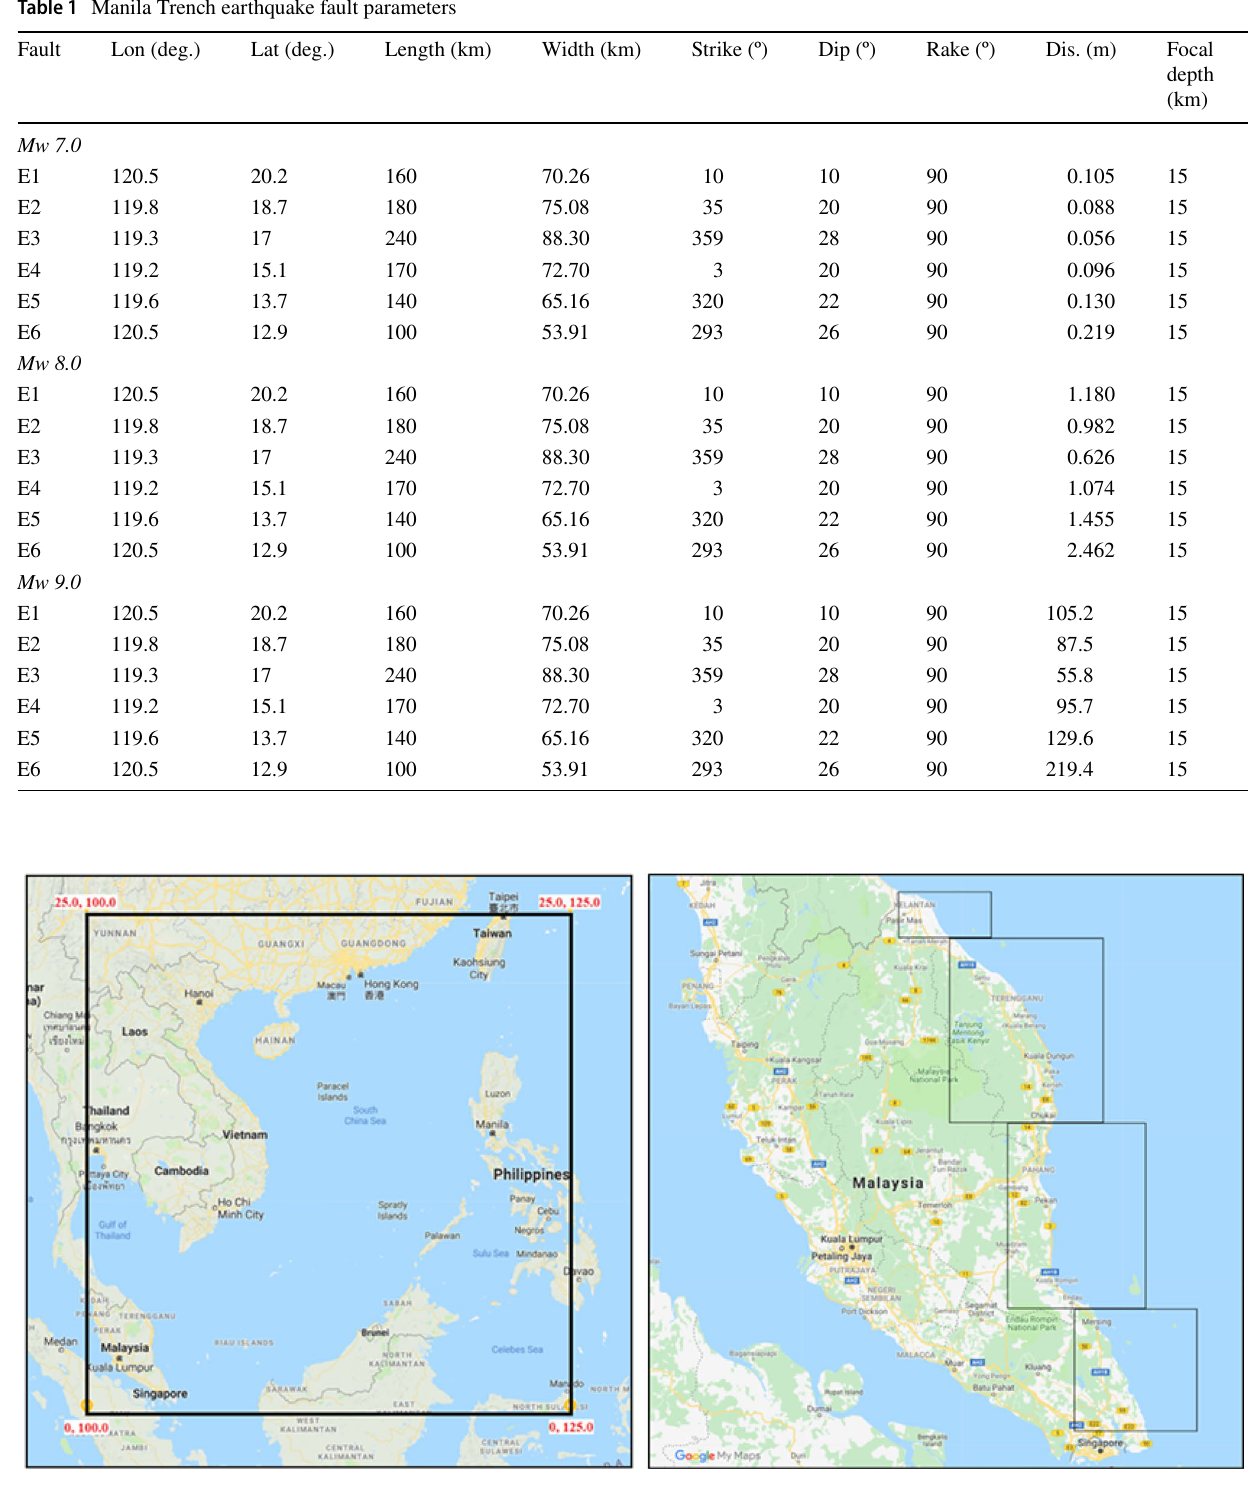
Fig. 2 Left: Proposed computational domain. Right: Proposed boundaries of study